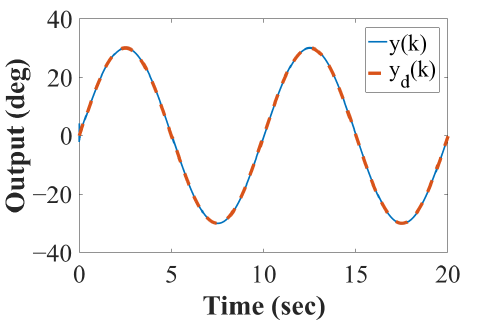
Figure 5. Output signals of the simulation in group 1 (original